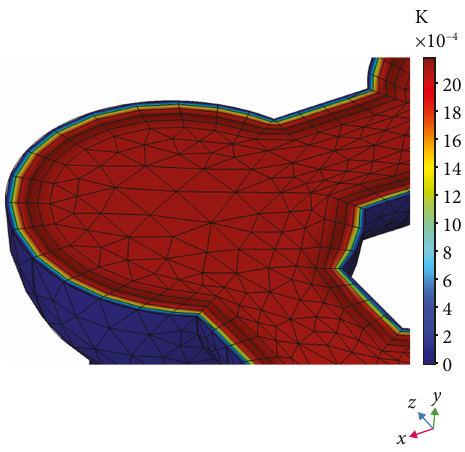
Figure 6: Temperature variation (K) unit cell at f = 500Hz .